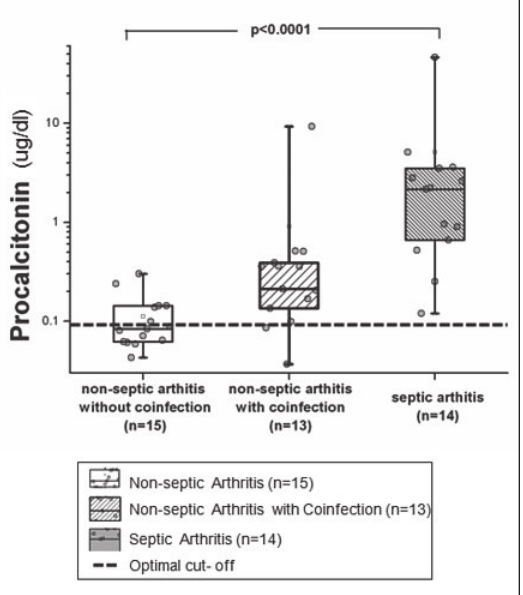
Differentiation of septic and non-septic arthritis. Early